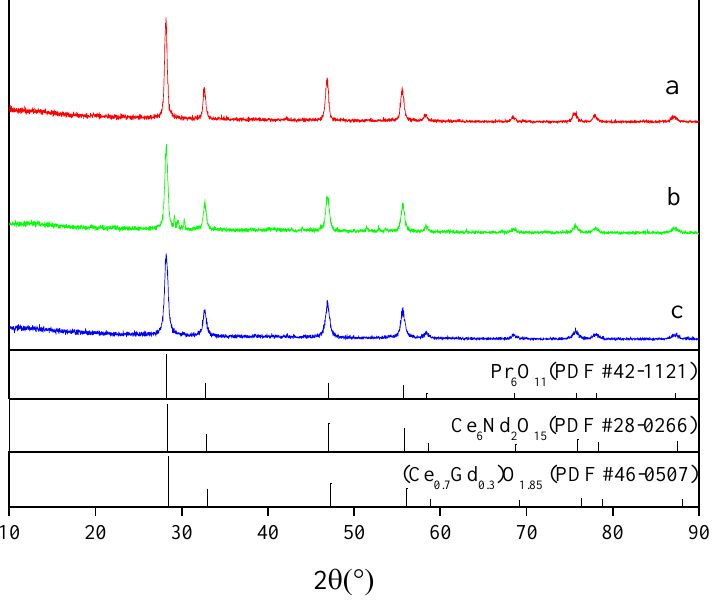
Figure 14. XRD pattern of RE x O y ( a ) calcination products of RE 2 (C 2 O 4 ) 3 ·10H 2 O; ( b ) calcination products of RE 2 (CO 3 ) 3 · 8H 2 O; ( c ) calcination products of RE(OH) 3 ).